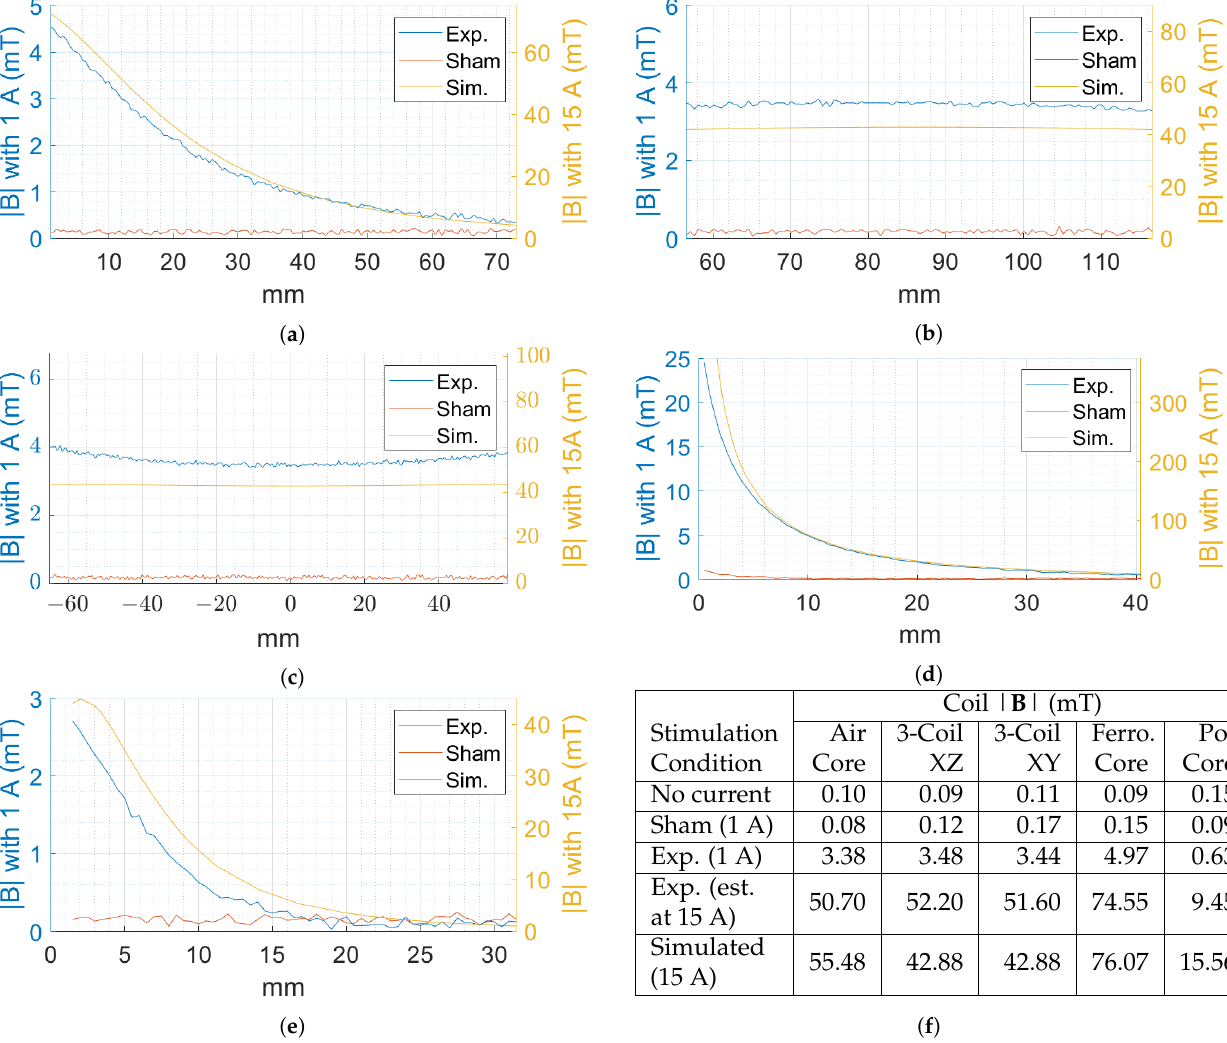
Figure 5. Line scans showing the experimental, sham, and simulated | B | along the red line depicted in the corresponding distribution images of Figure 4 for the ( a ) air core coil; ( b ) three-axis XZ; ( c ) three-axis XY, ( d ) ferromagnetic core coil; and ( e ) pot core coil scans. Experimental measurements were performed under a 1 A stimulation, simulated measurements were performed with 15 A, and the left and right axes of the graphs show the relationship between the | B | for a 1 A and 15 A stimulation, respectively; ( f ) summary of the | B | for the control, sham, experimental, and simulated conditions. Additionally, estimations of the | B | for each coil under a 15 A stimulation are included by linearly scaling the results from a 1 A stimulation by a factor of 15. Measurements are from a distance 10 mm from the coil along the central axis for the air, ferromagnetic, and pot core coils and at the center for the three-coil